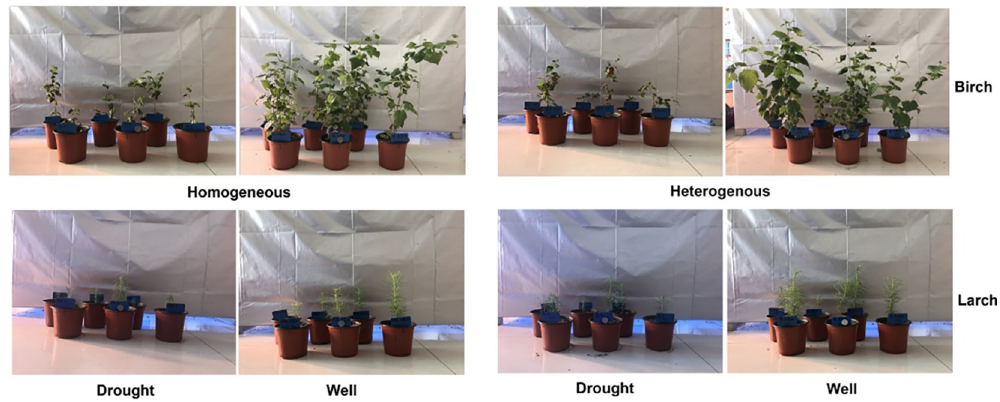
Fig 1. Performance of birch and larch seedlings cultured in heterogeneous and homogeneous nutrient environments in pots with drought and well-watered conditions. (Regent Ltd., Alberta, Canada) to quantify fine root morphologies of length, surface area, and